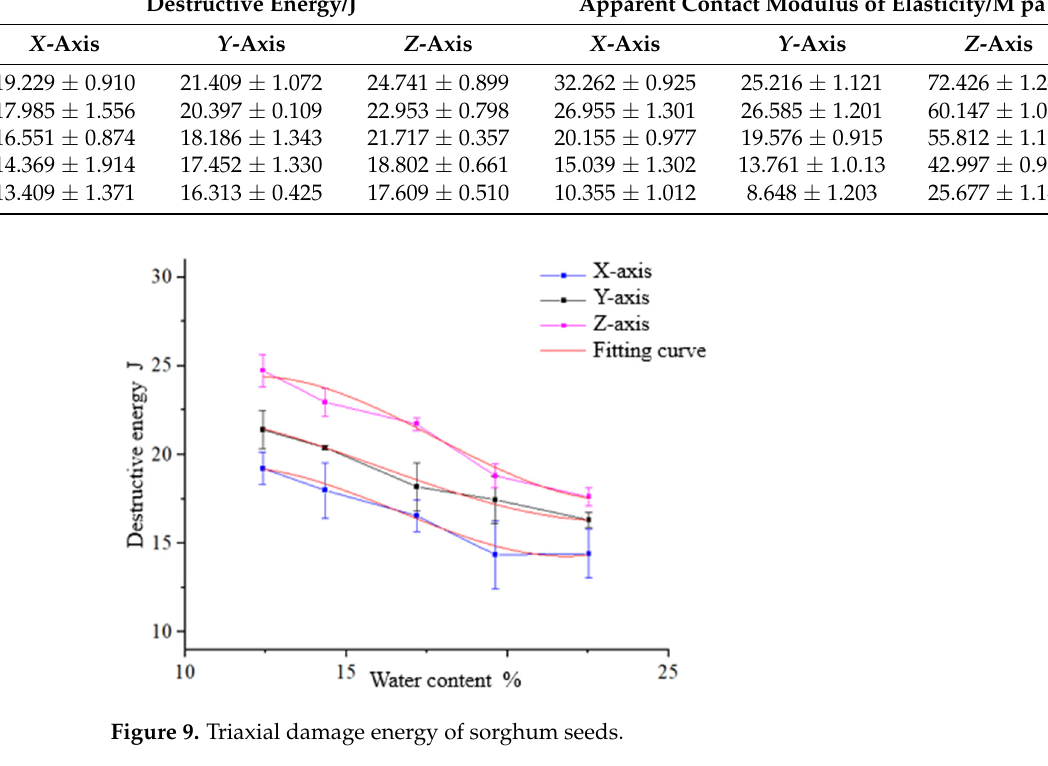
10 of 17 Figure 8. Surface diagram of maximum compression force in XYZ axis. ( a ) X -axis. ( b ) Y -axis. ( c ) Z - axis. It can be seen from Figure 8 that the magnitude of the injury force in the X and Z -axis directions is negatively correlated with the moisture content and size. In the Y -axis direc- tion, the magnitude of the damaging force is negatively correlated with the moisture con- tent and positively correlated with the size. The outer cells of sorghum seeds are keratin- ized and harder, with a tighter structure along the Y -axis, requiring more destructive force. At the same moisture content, the Z -axis can withstand the largest compression force, followed by the Y -axis, and the X -axis can withstand the smallest compression force. When compressing in the X -axis direction, the compression probe was in contact with the pointed relics at the top of the sorghum grain. Since the contact area between the two contact points is small, stress concentration is likely to occur. The top of the sorghum grain is weakly compressed, so it is easily damaged and cracked, and the contact area is smallest when compressed in the X -axis direction, so the smallest damage force is required when